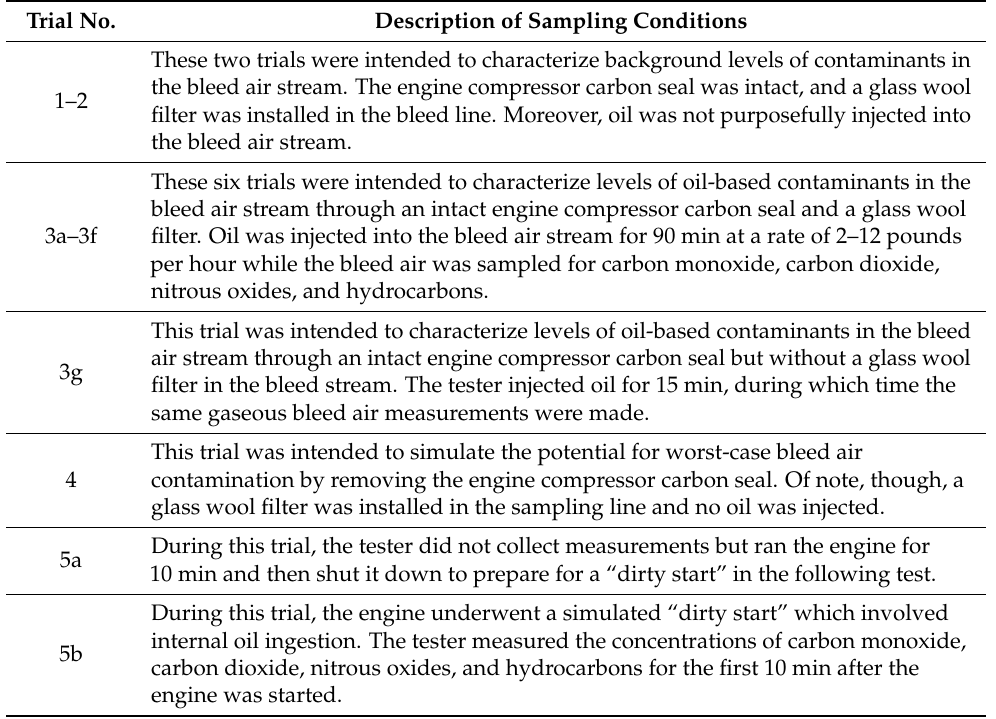
Table 6. Description of TPE331 engine bleed testing, per NTSB report